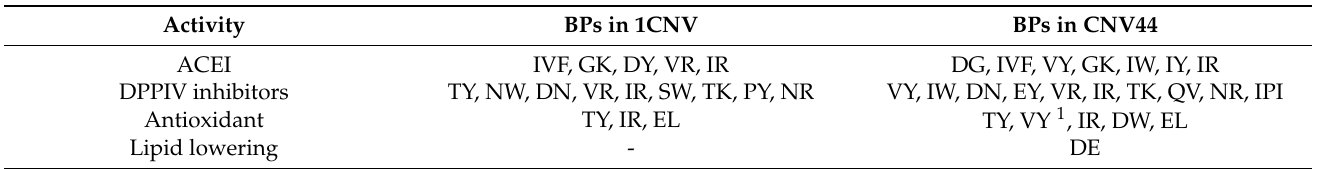
Table 2. Comparison of BPs profiles between 1CNV and CNV44 after in silico gastrointestinal digestion.